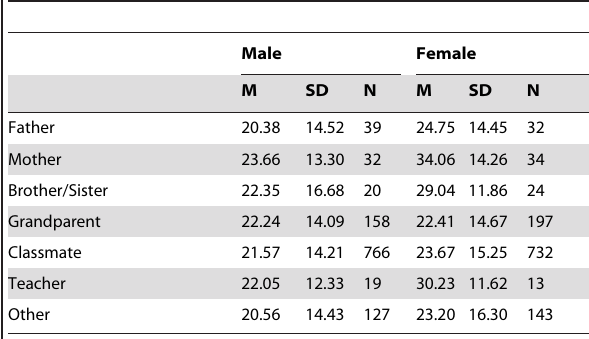
Table 6. Experience of separation from various individuals and average PTSSC-15 score.